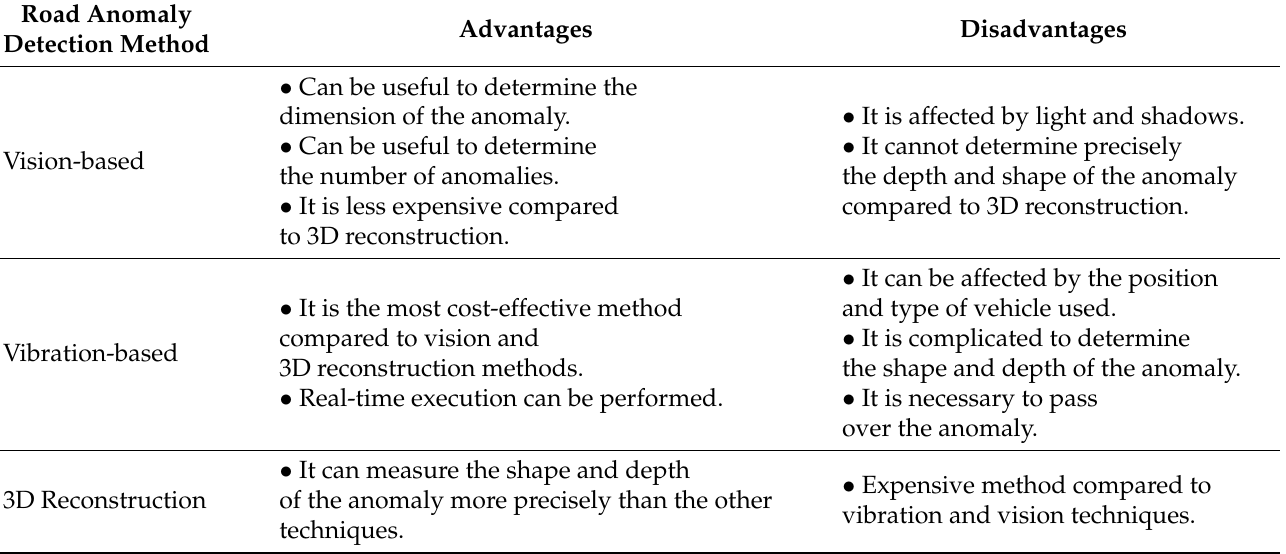
Table 1. Advantages and disadvantages of road surface anomaly detection and classification tech- niques